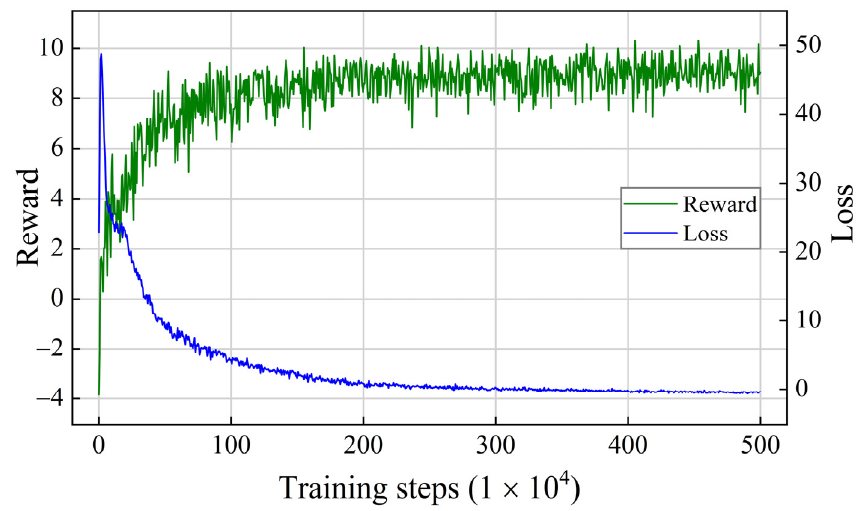
Figure 11. Learning curves of parameter combination E.